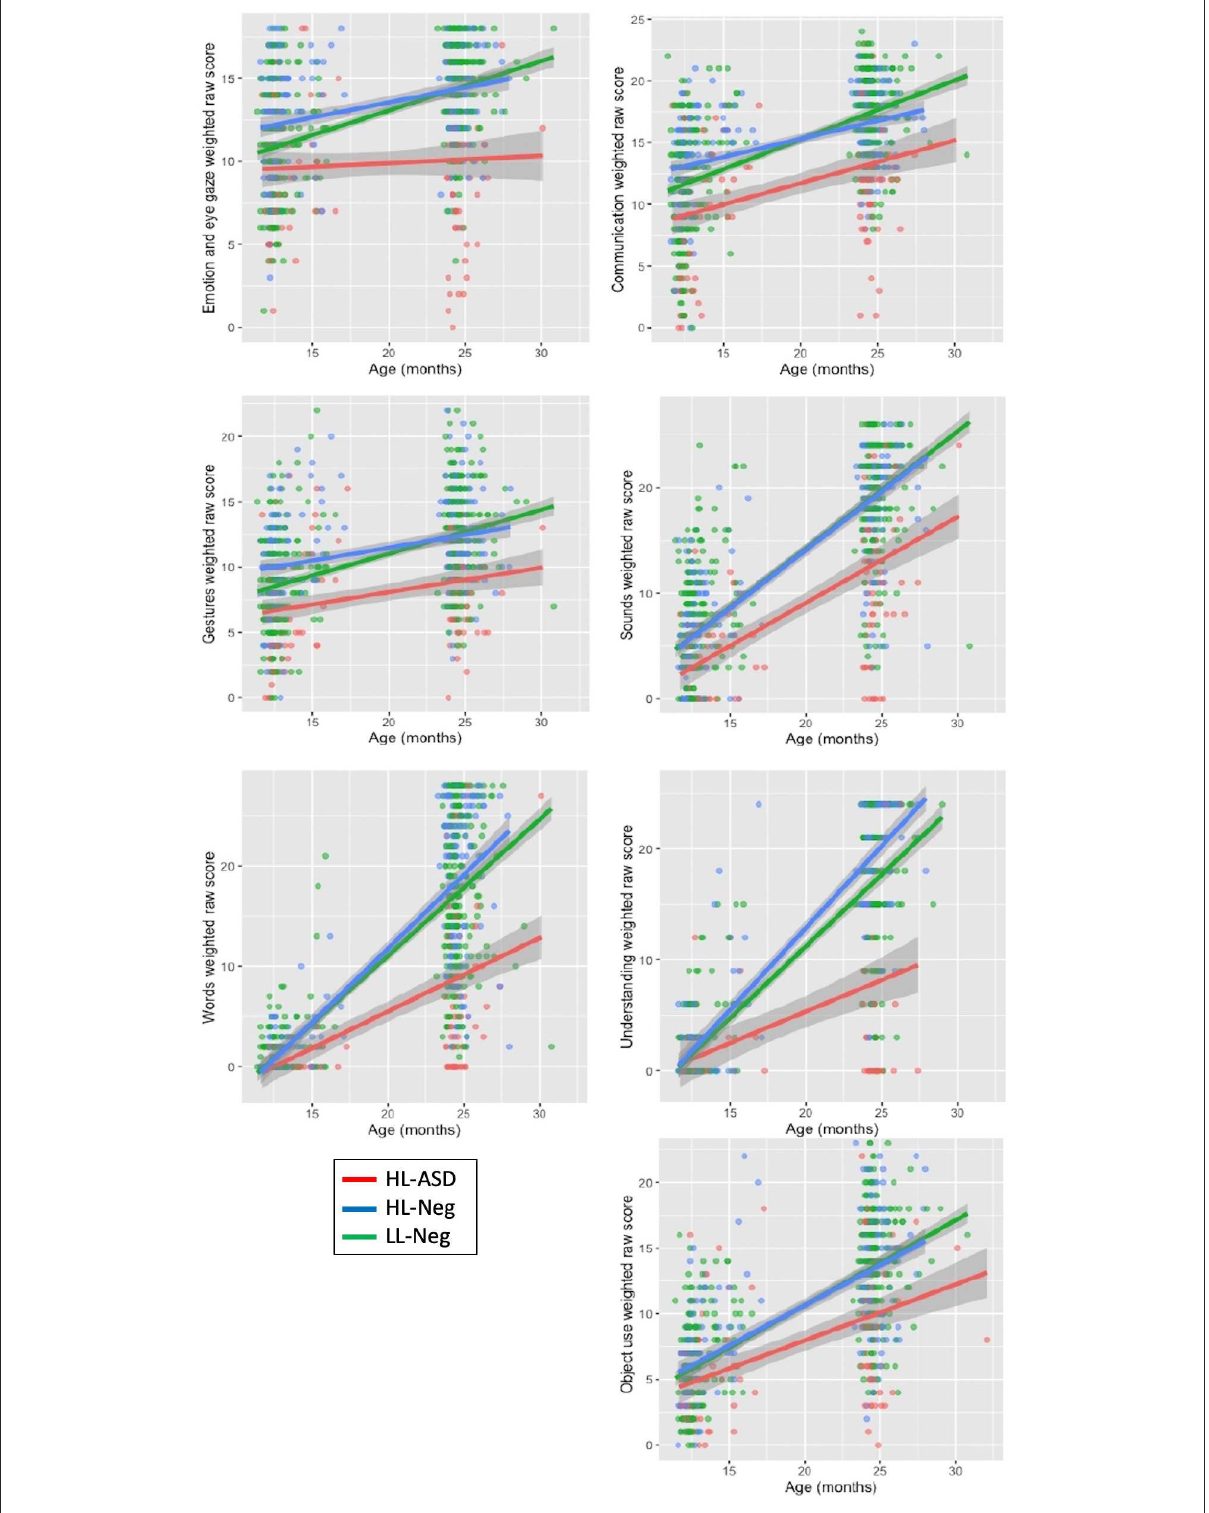
FIGURE1 Developmental trajectory of CSBS scores by